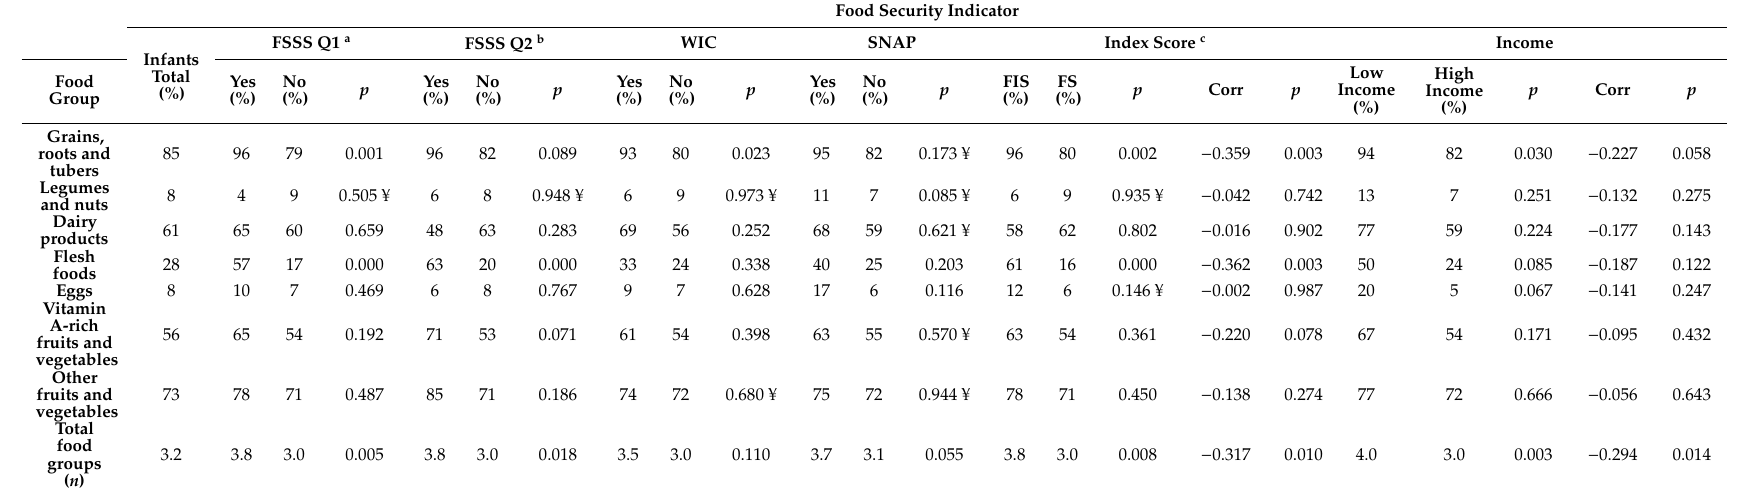
Table 5. Mean percent daily food group consumption by various indicators of food security applied in this analysis for infants aged 3–12 months enrolled in the cross-sectional study ( n =